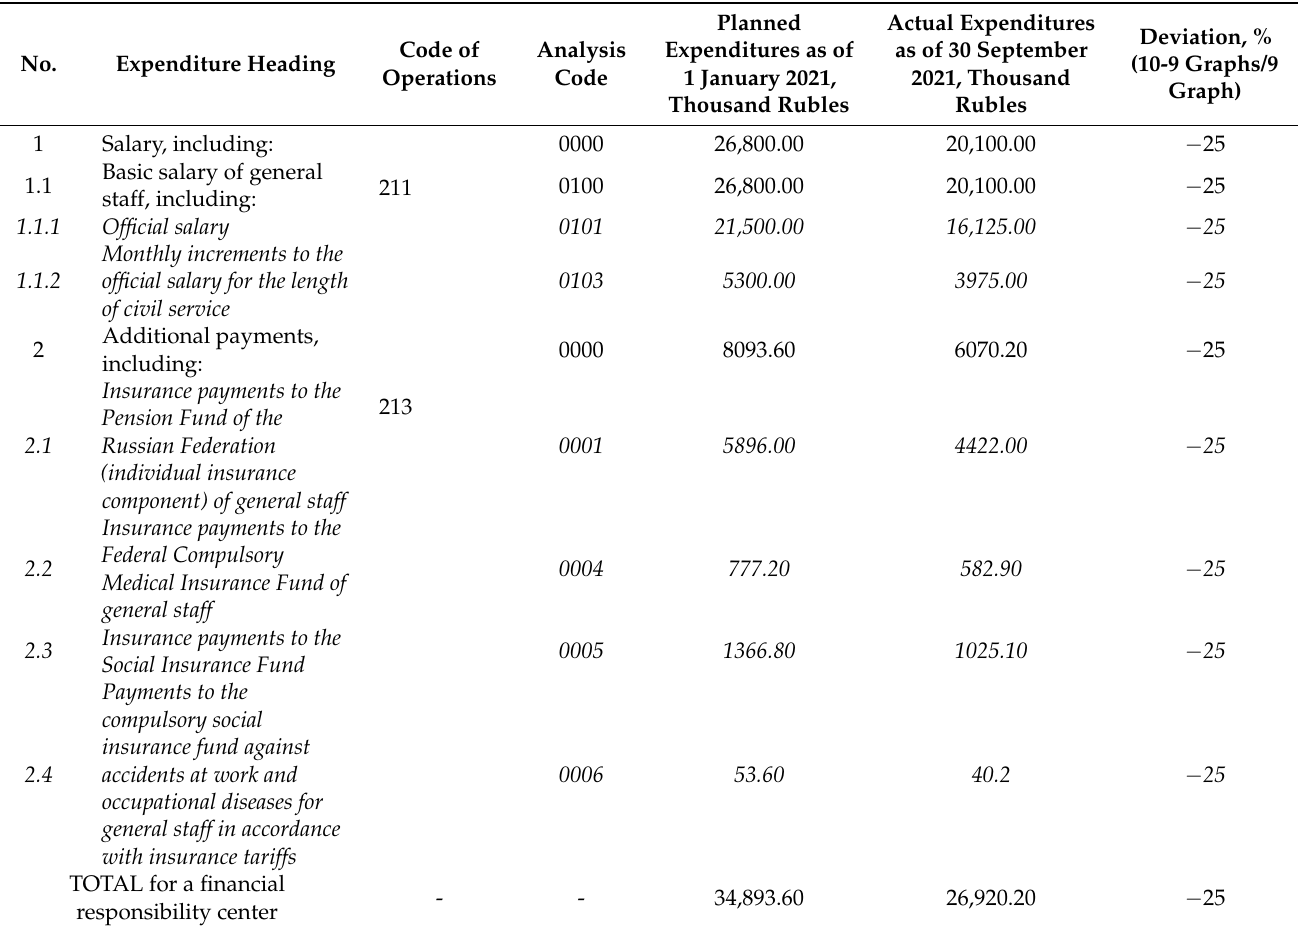
Table 5. The proposed form of the register “Budget expenditure reports of financial responsibility centers (cost centers)” (with due regard to conditional information)